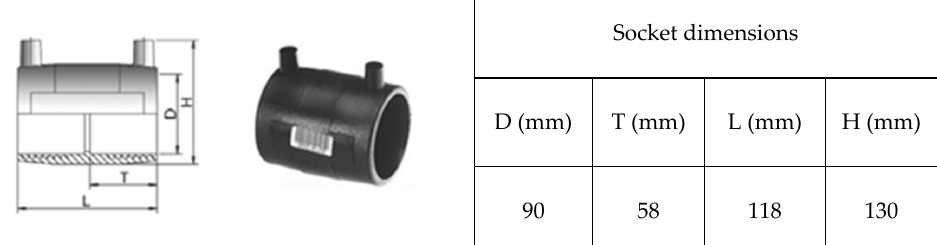
Figure 2. Selected socket geometry and dimensions for the investigated PE pipe [18]. D: Socket inside diameter; T: Inner length; L: Socket length; H: Socket height.